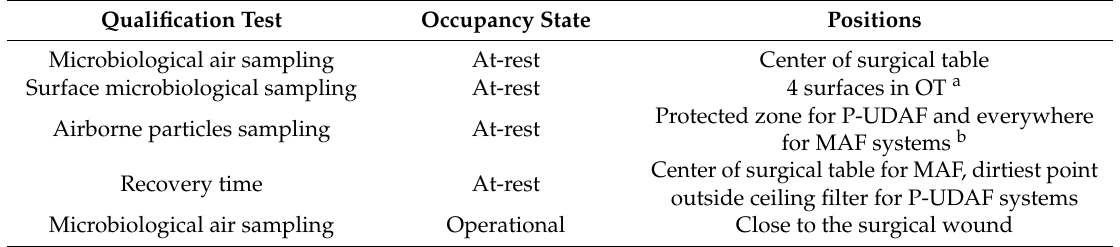
a surgical table, scialytic lamp, surgical instruments table, anesthesia tower. b sampling points under ceiling HEPA filter for ISO Class 5 OTs (P-UDAF) according to ISO 14644-1:2015 [46]; sampling points evenly distributed according to ISO 14644-1:2015 [46] for ISO Class 7 OTs (P-UDAF and